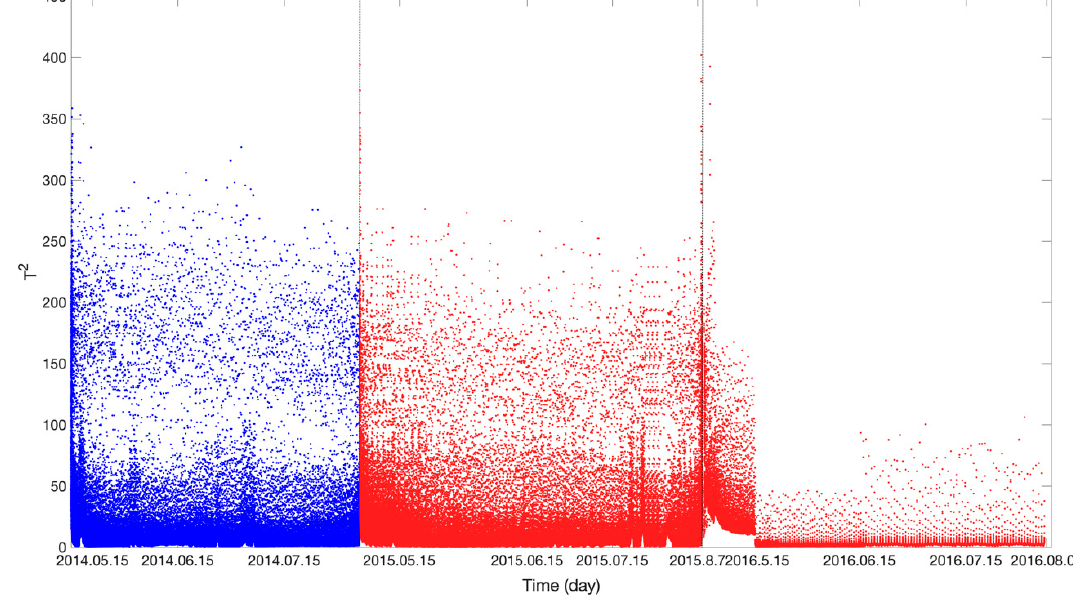
Figure 11. LLE algorithm anomaly-detection result (T 2 ).